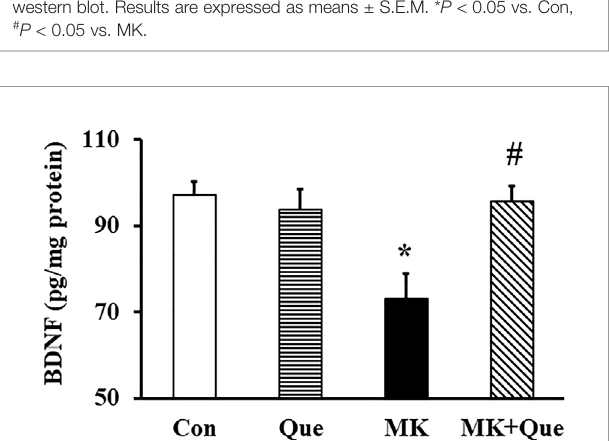
FIGURE 5 | Brain-derived neurotrophic factor (BDNF) protein level in the frontal cortex of mice in control (Con), quetiapine (Que), MK-801 (MK), and MK-801+quetiapine (MK+Que) groups. Quetiapine attenuated the decrease of BDNF level in the frontal cortex of MK-801 mice. n=5 in each group. Mice were treated with chronic quetiapine (10 mg/kg/day, intraperitoneally) for 28 days. From day 22 to 28, 1 h after the administration of quetiapine, the mice were administered MK-801 (2 mg/kg/day, subcutaneously). One day after behavioral testing, the mice were sacri fi ced for BDNF protein analysis by ELISA. Results are expressed as means ± S.E.M. * P < 0.05 vs. Con, # P < 0.05 vs.